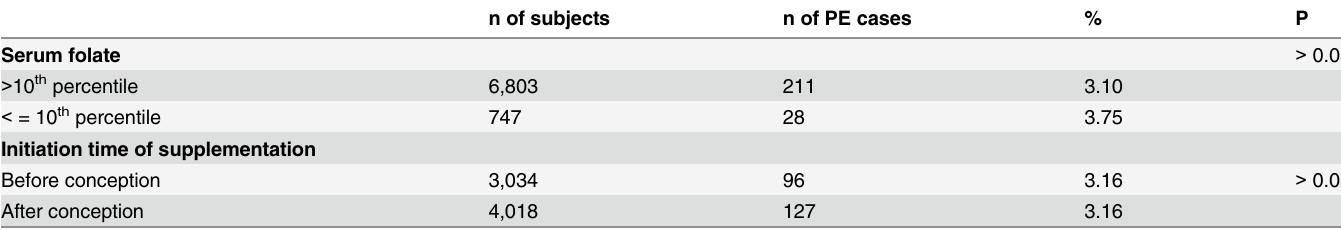
Table 6. Association between serum folate concentration and PE and according time of folic acid supplementation. n of subjects n of PE cases % P